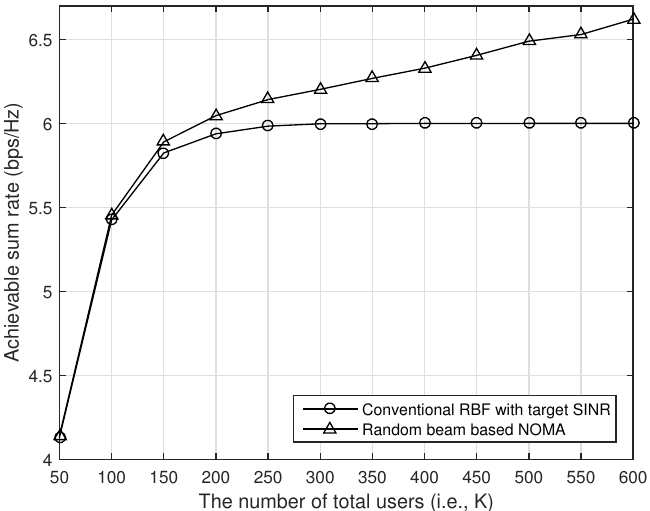
Figure 4. The performance of our proposed random beam-based NOMA with respect to the number of users when the transmitter has six antennas, and SNR is 10 dB.